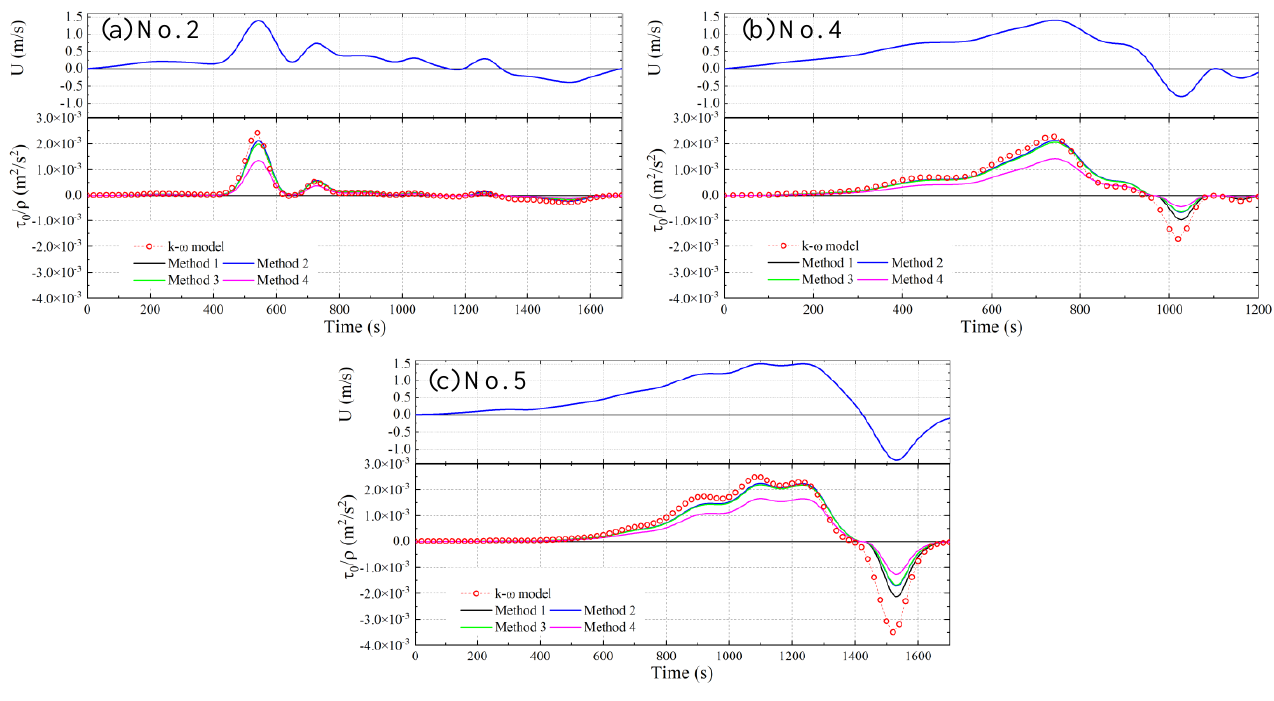
Figure 12. Flow velocity and bottom shear stress at the measuring point ( a ) No. 2, ( b ) No. 4, and ( c ) No. 5.